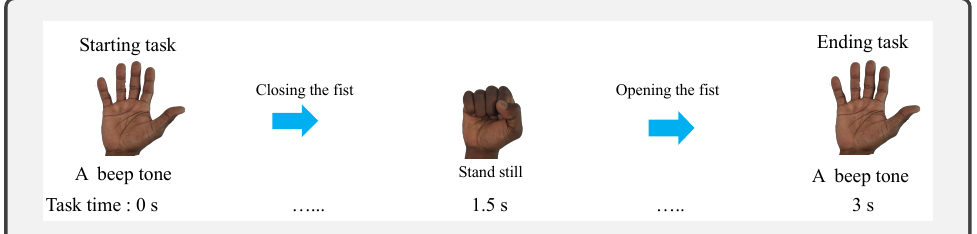
Figure 5. The MI task video serves as a subject stimulus. The task starts with a beep tone by closing the fist completely and opening the same fist until the end beep appears. Each task lasts 3